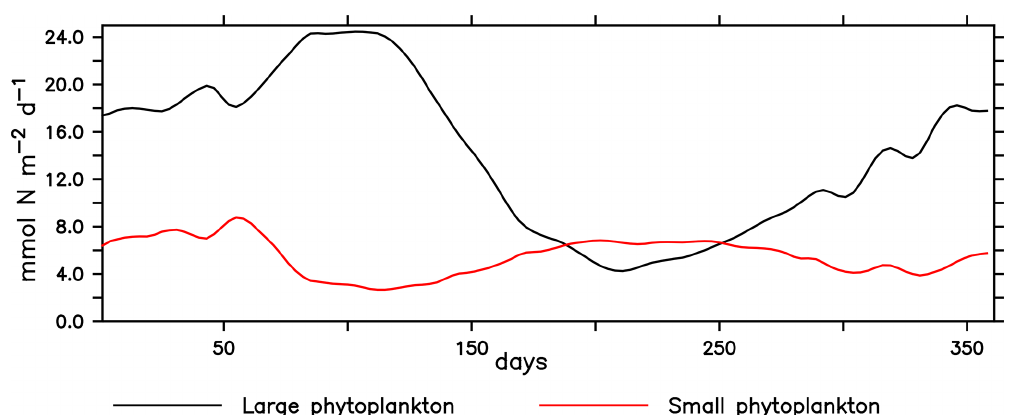
Figure C1. Primary production by large and small phytoplankton during the last climatological year of the simulation, averaged over the upwelling region (see Fig. 1) and integrated over the upper 100m in the reference